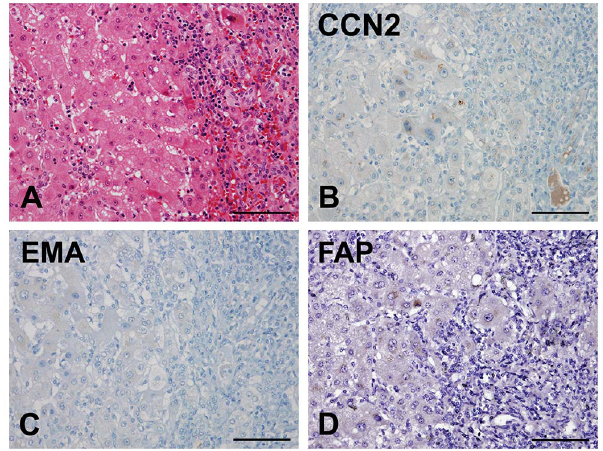
Figure 2. Connective tissue growth factor (CCN2), epithelial membrane antigen (EMA), fibroblast activation protein (FAP), and keratin 19 (K19) expression in liver cirrhosis. A) Liver cirrhosis showing regenerative hepatic nodules and fibrotic septa with chronic inflammatory cells. CCN2 (B), EMA (C), and FAP (D) expression is negative in both hepatocytes and benign stromal cells from cirrhosis specimens. (Scale bars represent 100 m m.)